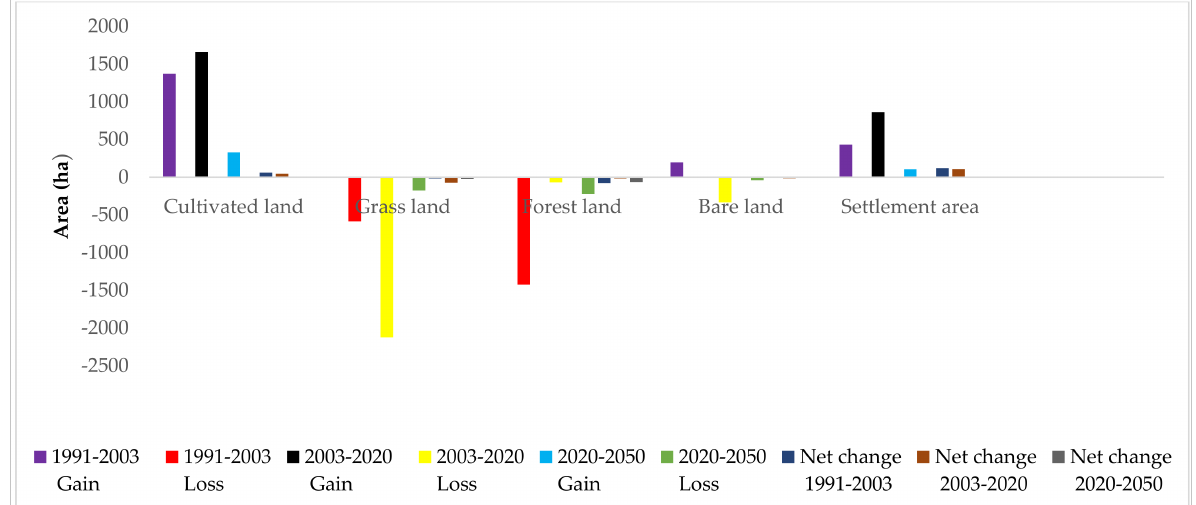
Figure 11. The gains, losses and net change of LULC Matenchose Watershed area (1991, 2003, 2020 and